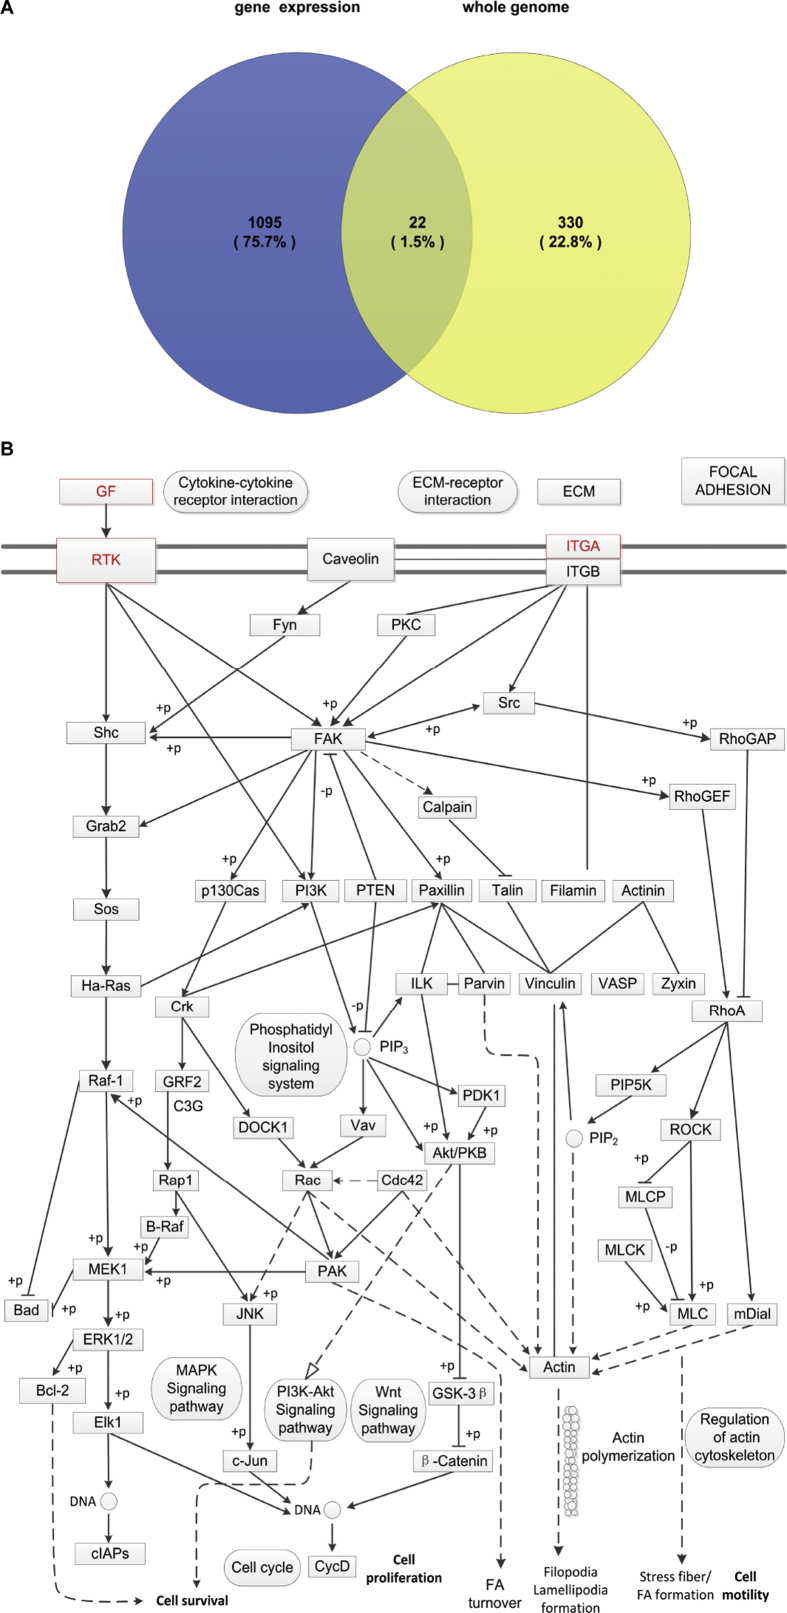
A.Venn diagram of shared genes between distinct gene expression profiling and whole genome sequencing data. B. KEGG pathway for local adhesion. The significant shared genes between distinct gene expression profiling and whole genome sequencing data are shown in red.